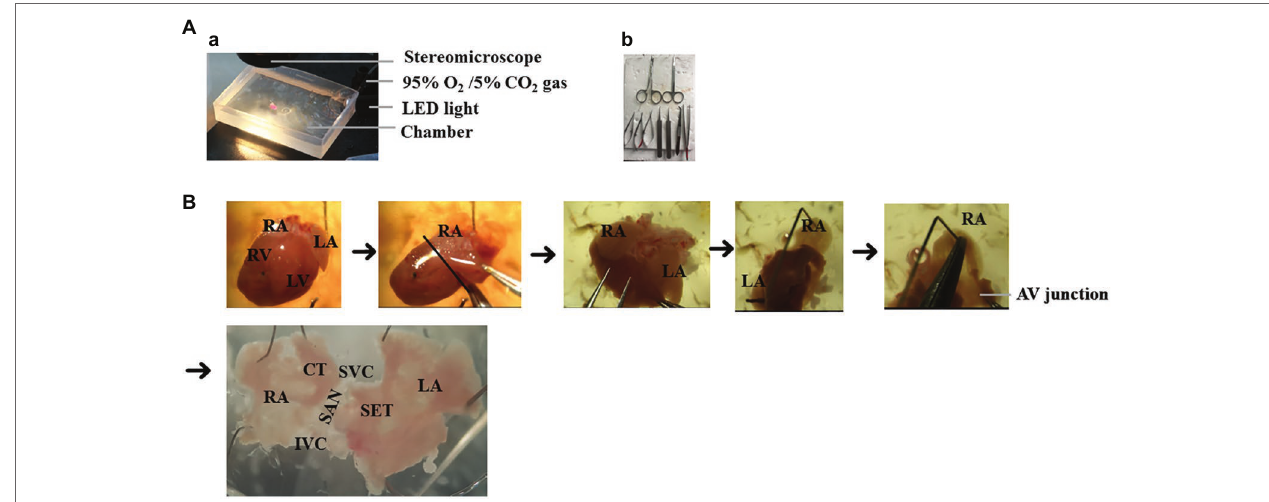
FIGURE 2 | The isolation of mouse SAP. (A) The setup of dissection. (a) The dissection was performed under the stereomicroscope and oxygenated PSS solution. (b) Surgical instruments. (B) The preparation of SAP. RA, right atrium; LA, left atrium; RV, right ventricle; LV, left ventricle; SAN, sinoatrial node; AV junction, atrioventricular junction, SET = septum, SVC = superior vena cava, IVC = inferior vena cava, CT = crista